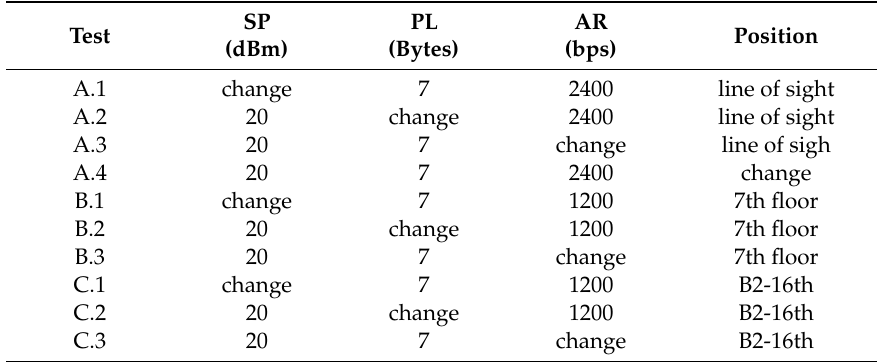
Table 3. Parameters setting of the